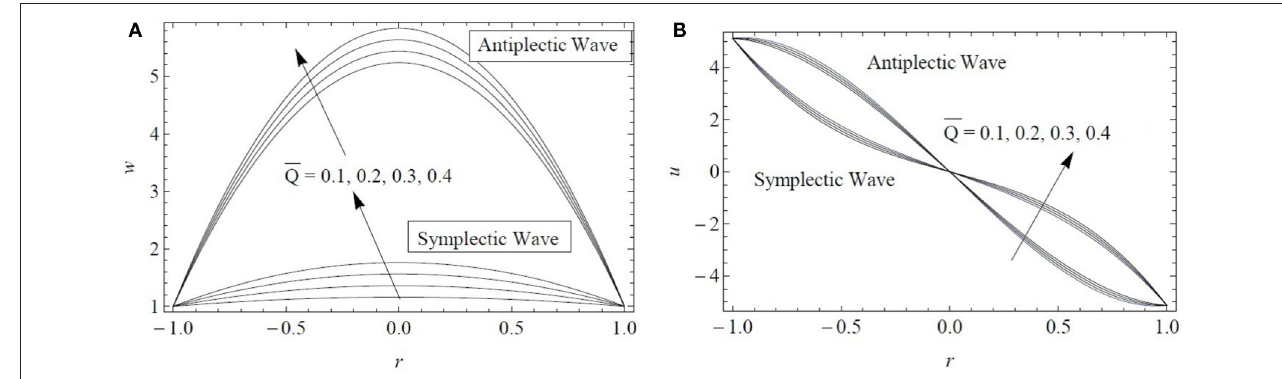
FIGURE 7 | Comparison in terms of the (A) axial and (B) radial velocity components plotted at z = 0.75 for both antiplectic and symplectic waves. Results obtained for ǫ = 0.2, α * = β * = 0.7, and ¯ Q =